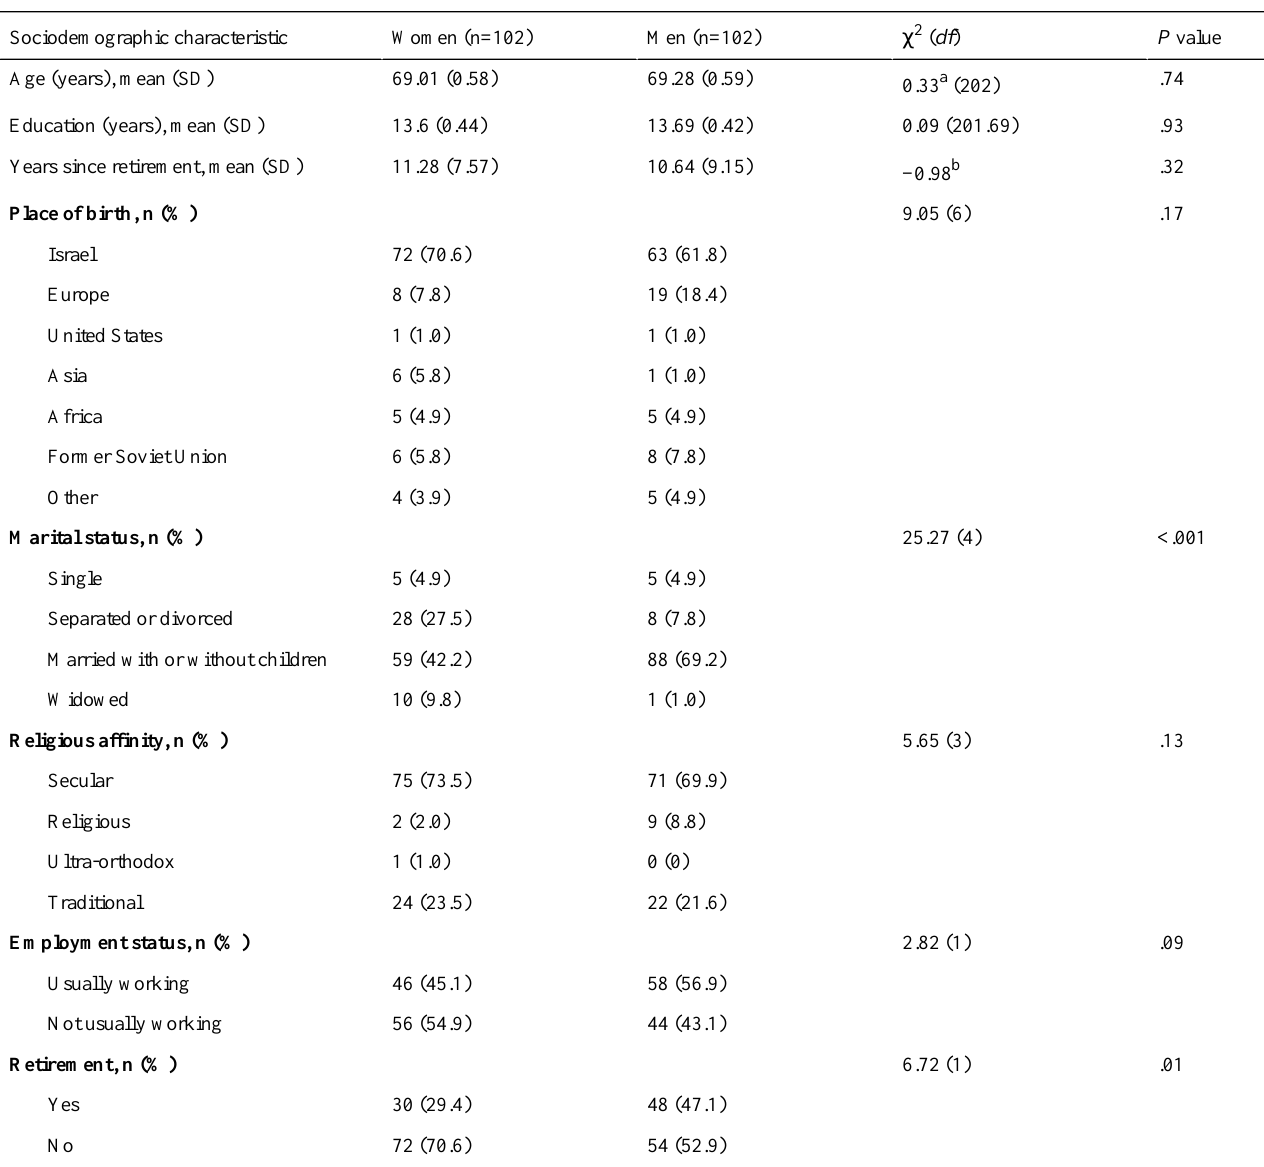
Table 1. Participants’sociodemographic characteristics by gender